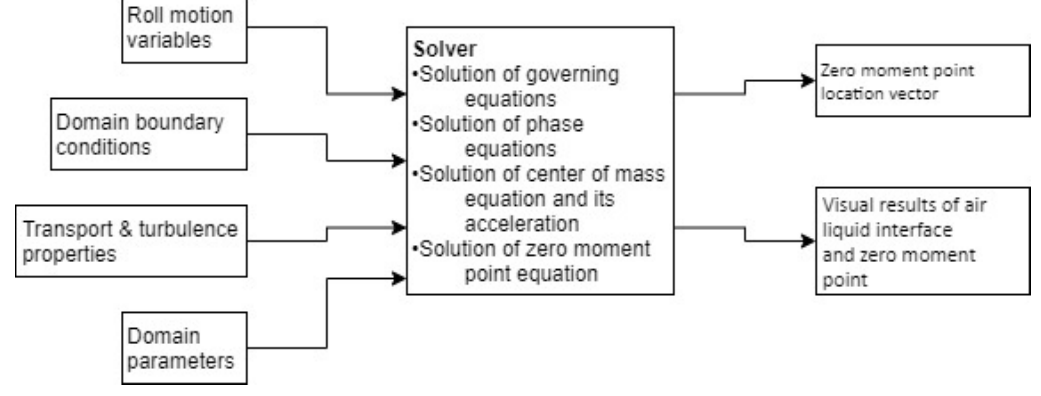
Figure 5. Outline of solver processes.